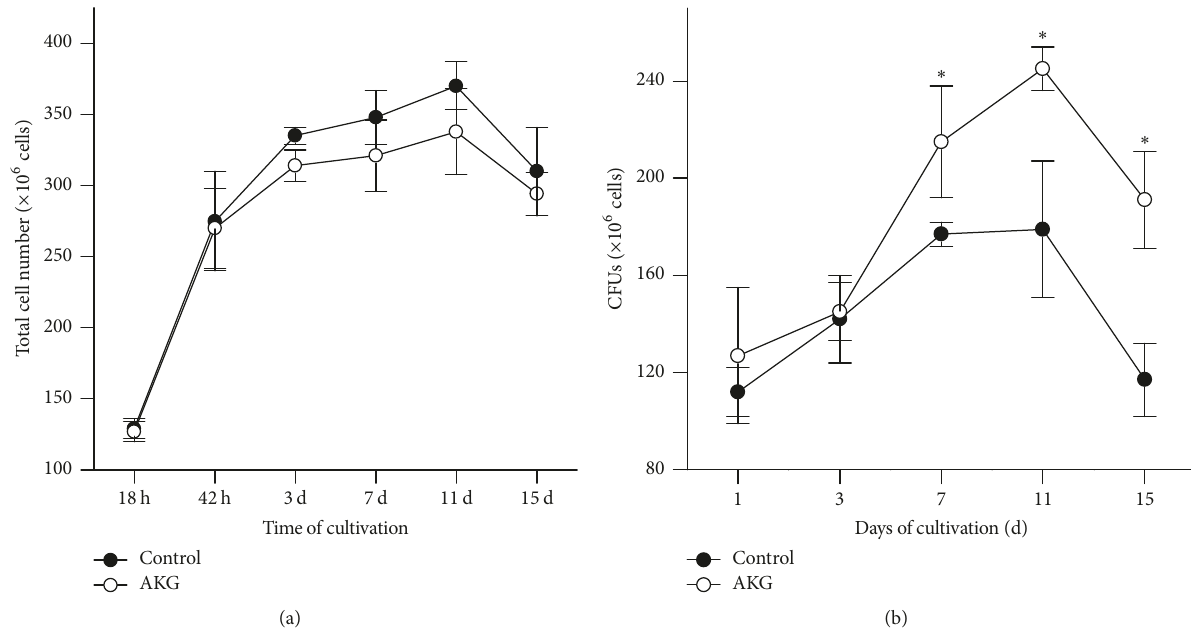
Figure 1: Effects of growth conditions on total cell number (a) and number of colony-forming units (CFUs) (b) in S. cerevisiae cultures. Yeast cells were grown during 7 days in the control medium or in the medium supplemented with 10mM AKG. The starting cell concentration in the medium was about 0.3 × 10 6 cells/ml. Results are shown as means ± SEM ( 𝑛 = 5 –7). ∗ Significantly different from respective control values with 𝑃 < 0.05 using Student’s t -test.